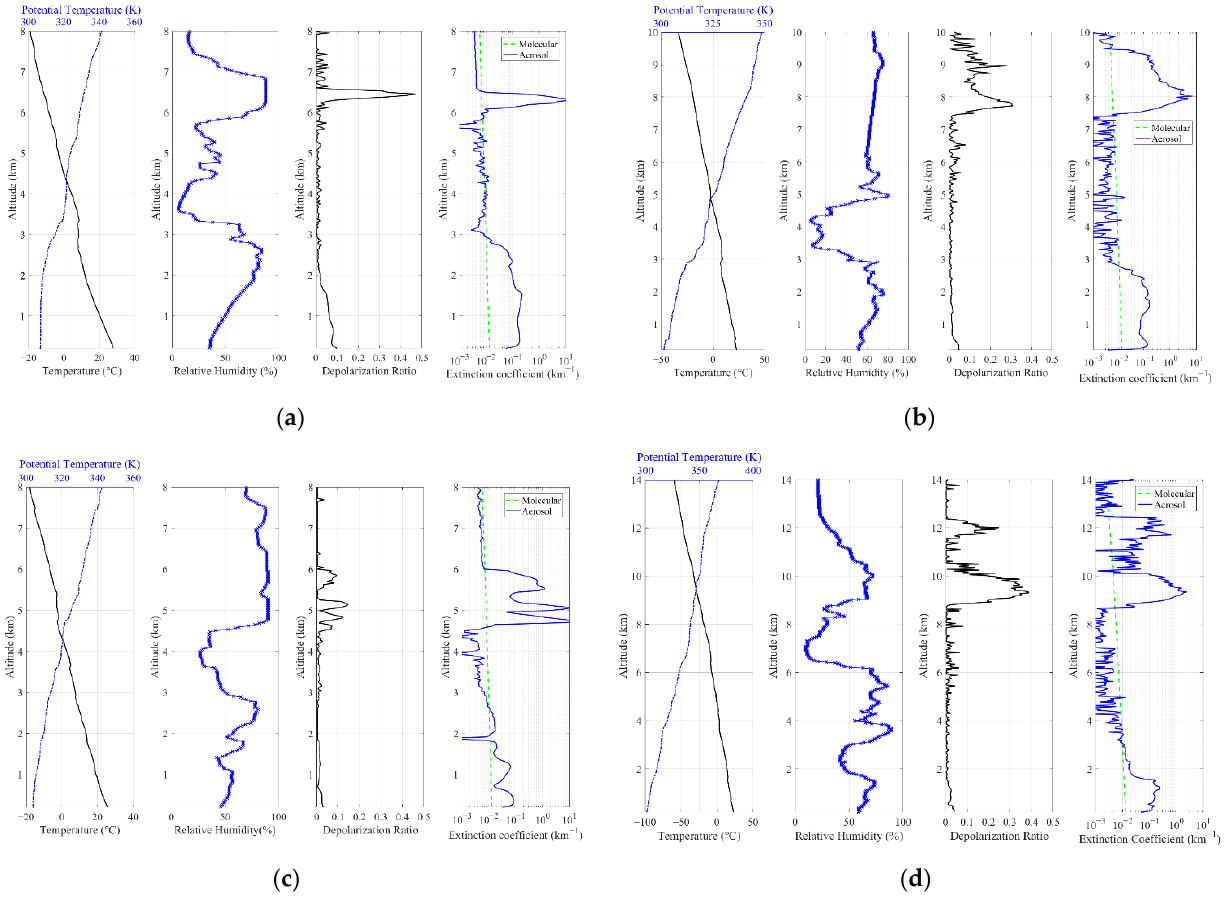
Figure 9. ( a )Data profiles of GTS1 Digital Radiosonde and lidar at 19:15 on 16 June 2019; ( b ) Data profiles of GTS1 Digital Radiosonde and lidar at 7:15 on 17 June 2019; ( c ) Data profiles of GTS1 Digital Radiosonde and lidar at 19:15 on 17 June 2019; ( d ) Data profiles of GTS1 Digital Radiosonde and lidar at 7:15 on 18 June 2019.